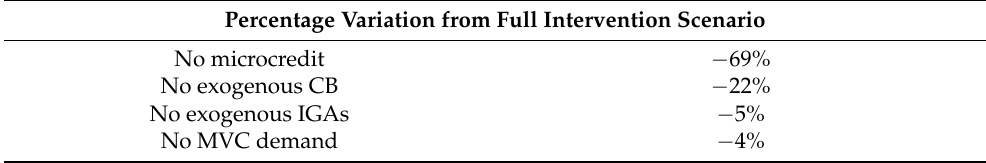
Figure 4. Impact of listed scenarios. Each scenario is built by neutralizing the effect of one com- plementary action. (MVC—Matembwe Village company; CB—capacity building; IGAs—income generating activities). Table 4. Quantitative results for different complementary activities, ranked with respect to